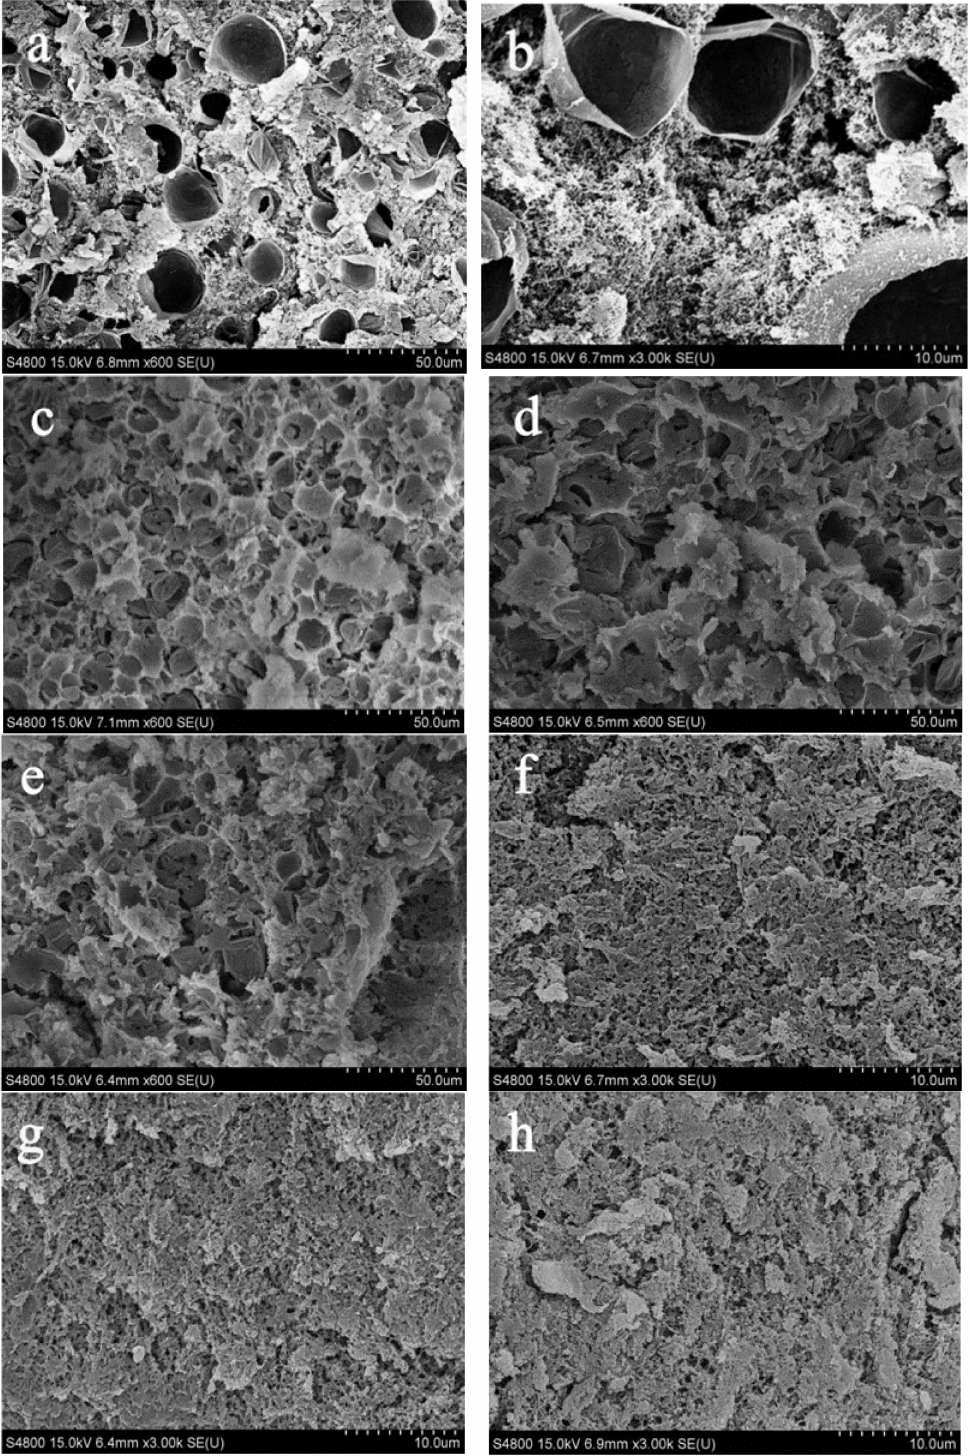
Figure 6. Microstructure of of different emulsion-filled gels. ( a , b ) MP gel, 600 and 3000 magnification, respectively; ( c ) PPP macro-emulsion composite gel, 600 magnification; ( d ) EPI macro-emulsion composite gel, 600 magnification; ( e ) SC macro-emulsion composite gel, 600 magnification; ( f ) PPP nano-emulsion composite gel, 3000 magnification; ( g ) EPI nano-emulsion composite gel, 3000 magni- fication; ( h ) SC nano-emulsion composite gel, 3000